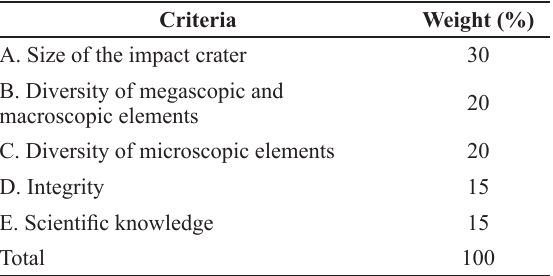
Weights for the different criteria used for the assessment of the scientific value of impact structures. criterion d is the arithmetic mean of d1, d2, d3, and d4 for complex craters and of d1, d3, and d4 for simple